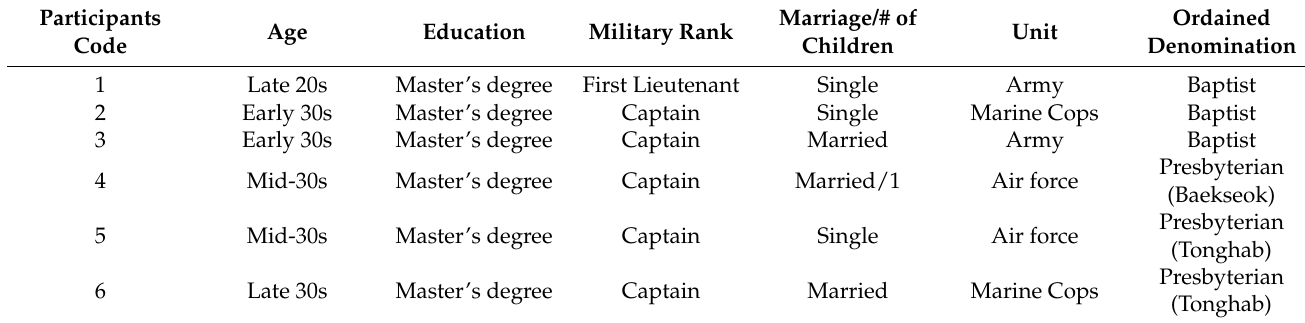
Table 1. Participant